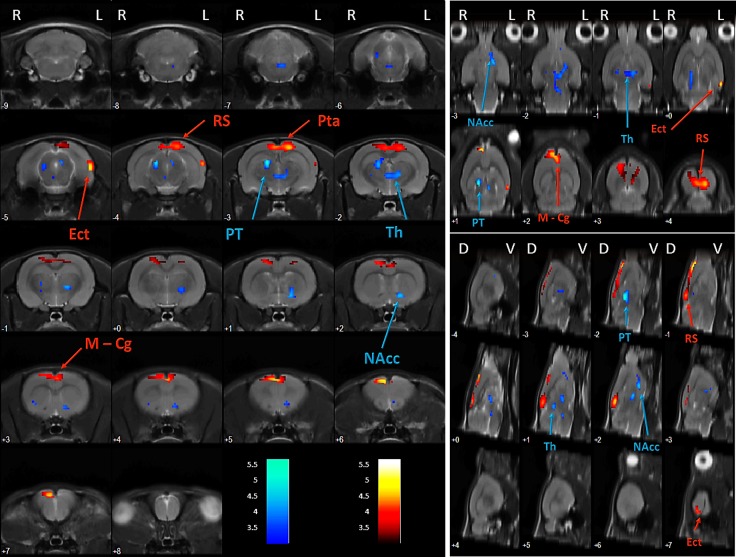
NAcc-DBS effects on brain metabolism.Axial (left), coronal (upper right) and sagittal (lower right) views of the brain. Colored PET overlays on the MR reference indicate increased FDG uptake (hot colors) or decreased FDG uptake (cold colors) 1 day after the end of the stimulation in NAcc. Left (L), right (R), dorsal (D), ventral (V).